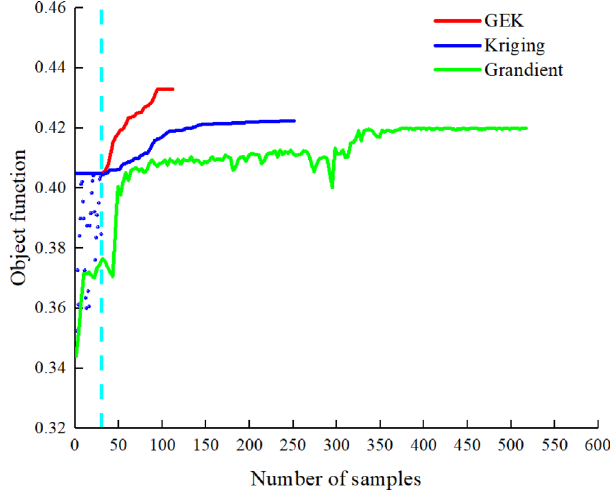
Figure 6. Convergence history of the design objective function at full